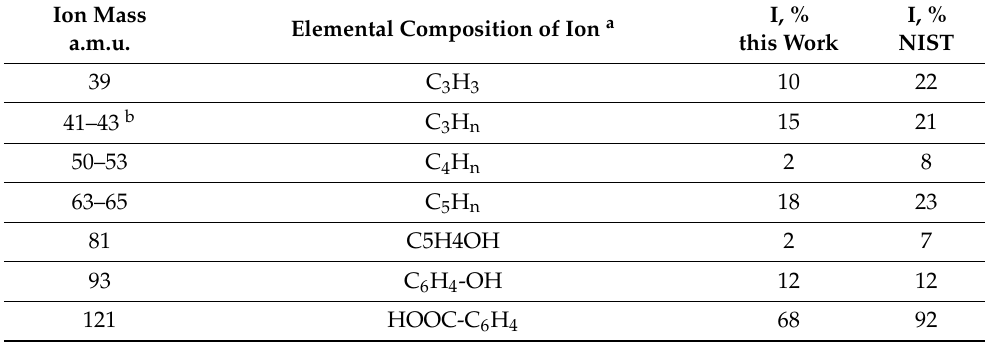
Table 2. Ions recorded in the mass spectrum of POBA in this work (MI-1201) and NIST. Ion Mass Elemental Composition of Ion Ion Mass a.m.u.